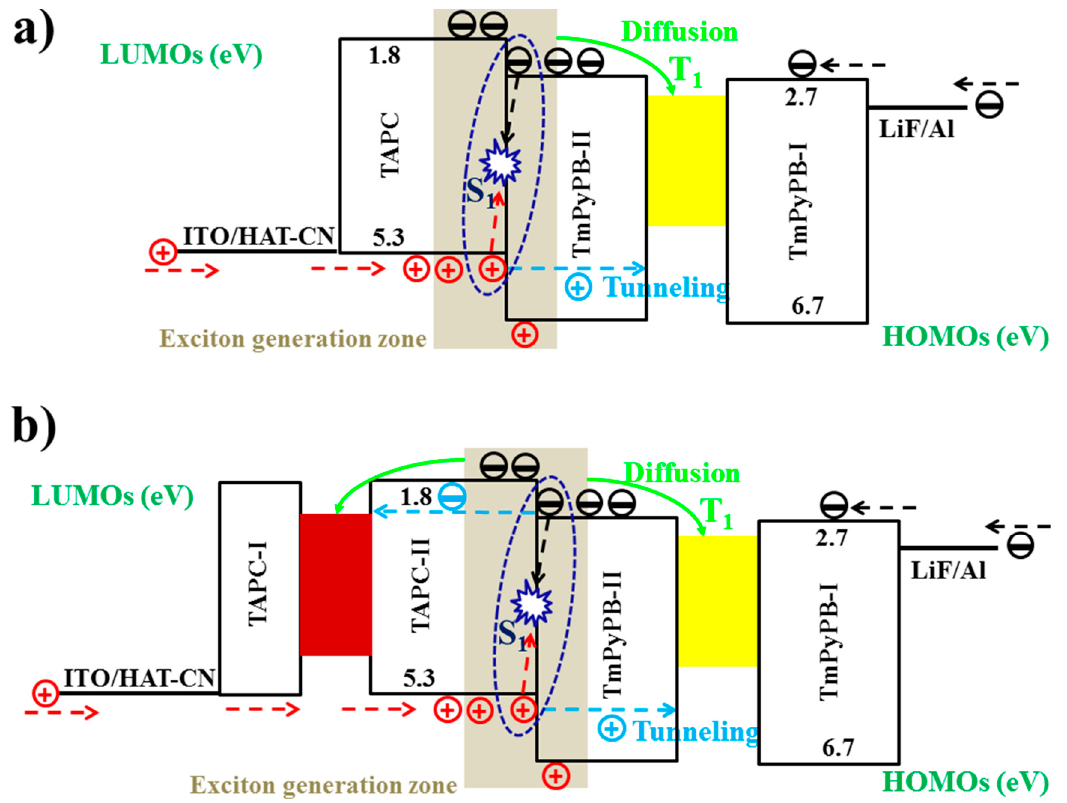
Figure 5. Working mechanisms for ( a ) WOLED-I; ( b ) WOLED-II [173].